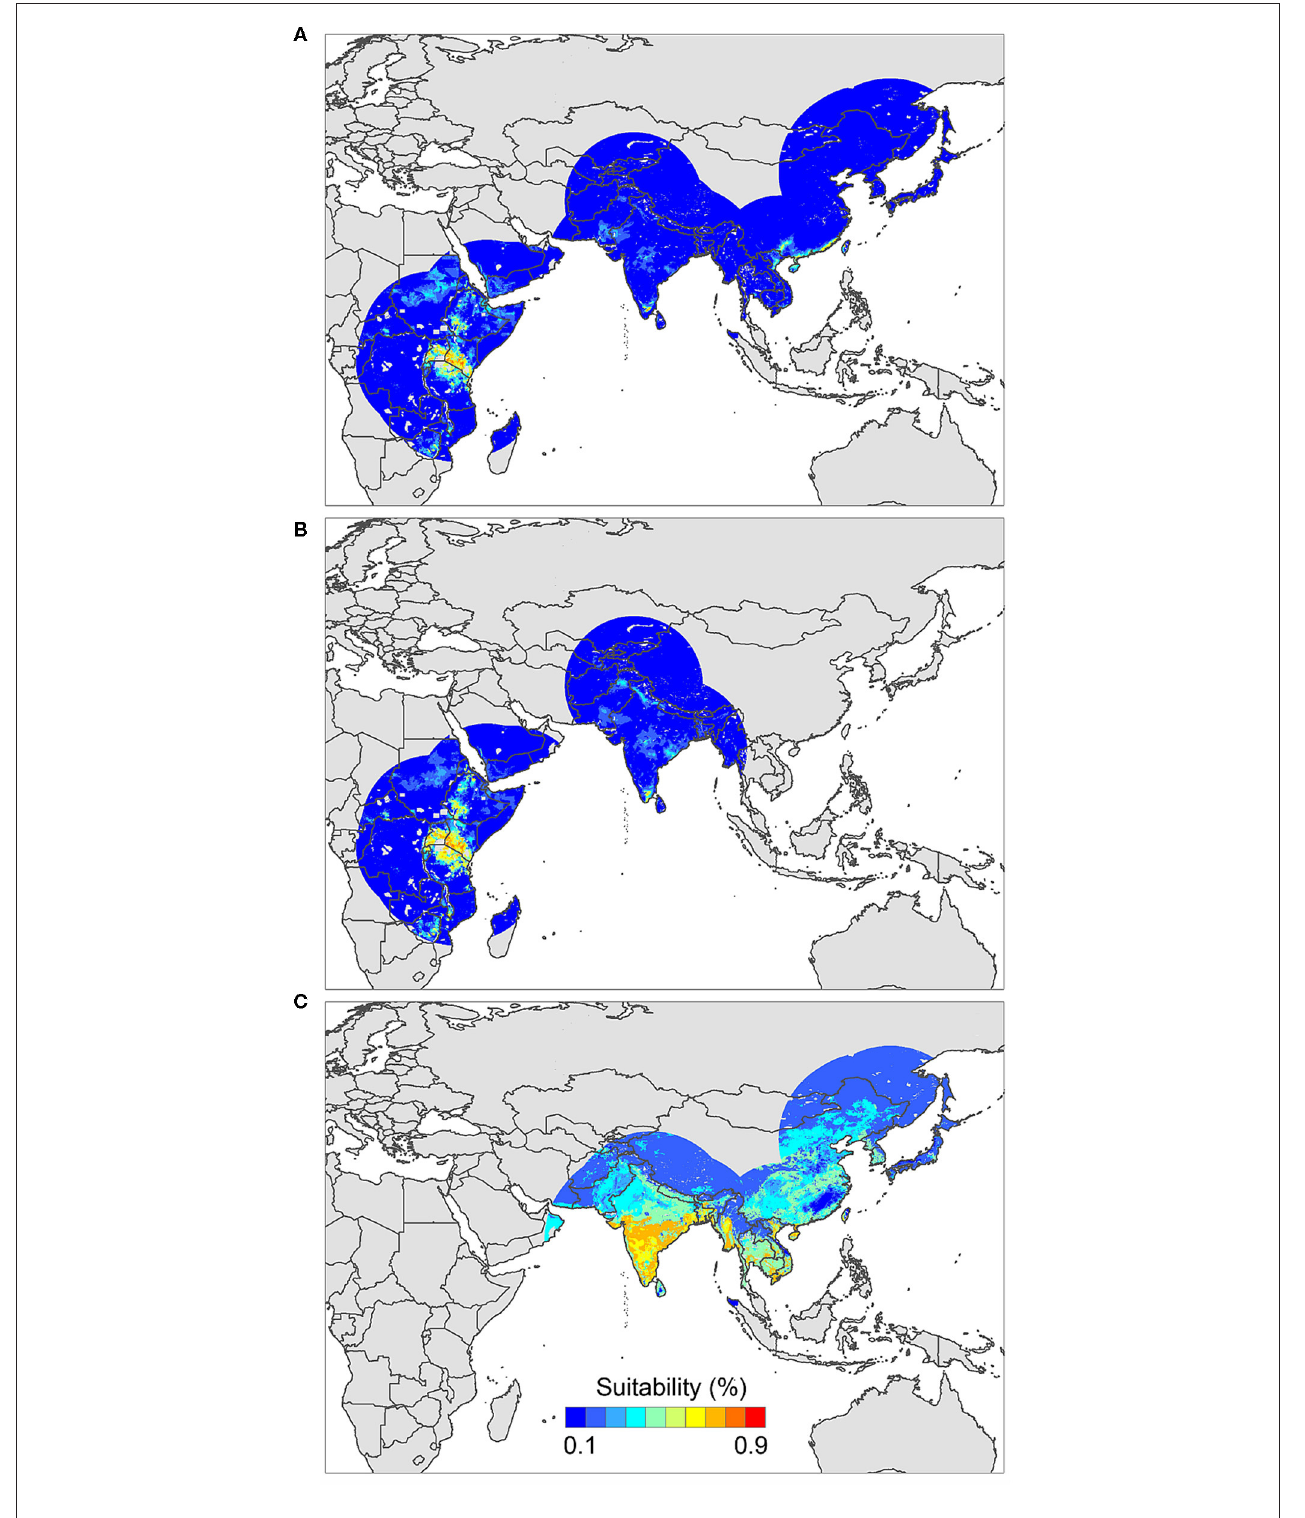
FIGURE 7 | Ecological niche models of (A) hosts and ticks, (B) hosts, and (C) tick circulation. Warmer colors represent areas with higher environmental suitability.